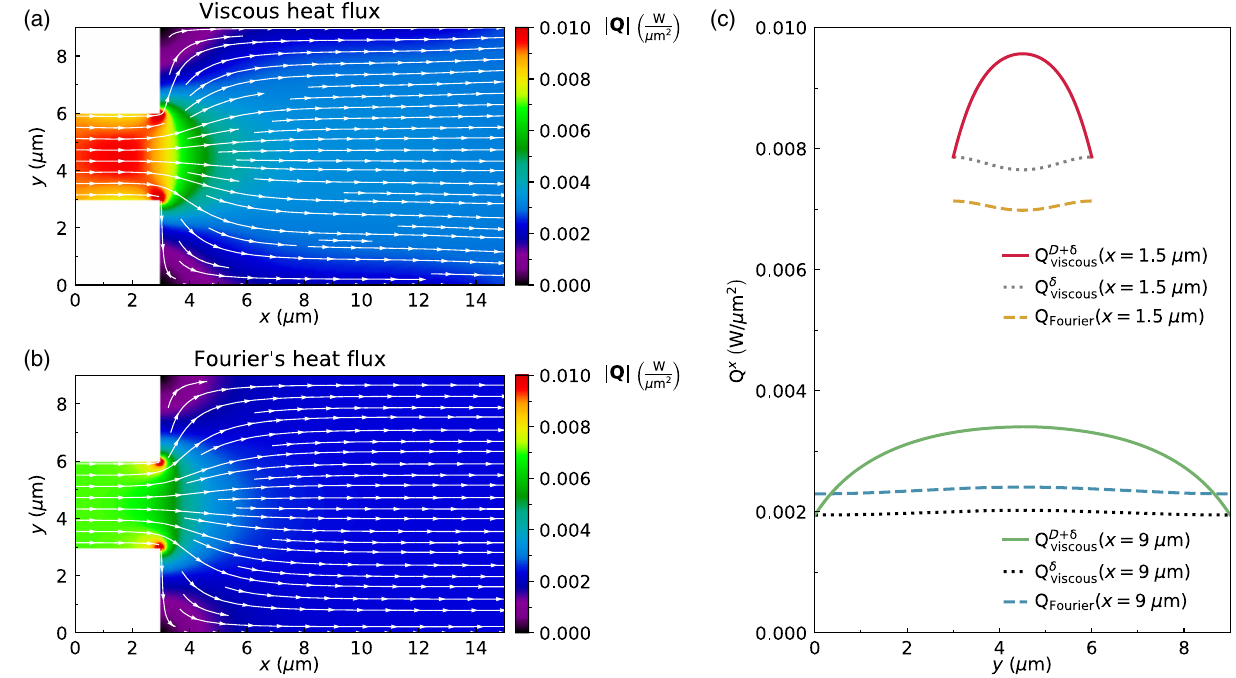
¯ T FIG. 3. In-plane ( x - y ) heat fluxes in graphite around ¼ 70 K, for a sample infinite in the z direction (the z direction of the sample coincides with the off-plane direction of graphite). Panel (a) shows the total heat flux ( Q D þ Q δ ) obtained from the viscous heat P κ ij ∇ j T ð r ; t Þ ] obtained solving the steady- equations (10) and (11). Panel (b) shows instead the Fourier heat flux [ Q i ð r ; t Þ ¼ − P j Fourier κ ij ½ ∂ 2 T ð r ; t Þ = ∂ r i ∂ r j (cid:2) ¼ 0 . Boundary conditions are as follows: the temperature is set at 80 K (60 K) on the state Fourier equation, ij left (right) boundaries, a zero total heat flux is imposed at the other boundaries, and zero drift velocity is imposed on all boundaries (no- slip boundary condition). With this choice of boundary conditions, the phonon distribution reduces to the Bose-Einstein distribution on the left and right boundaries, where the temperature is fixed. Despite having local equilibrium at the left and right boundaries, a nonzero drift velocity is present in the material as a consequence of the coupling in Eq. (10) between drift velocity and temperature. Panel (c) shows the x component of the heat flux along sections taken at x ¼ 1 . 5 μ m (orange, gray, red) and x ¼ 9 . 0 μ m (black, blue, green); solid lines are the results obtained from the viscous heat equations, dashed lines are the results from Fourier ’ s law, and dotted lines are the heat fluxes due to the temperature gradient within the viscous heat equations ( Q δ